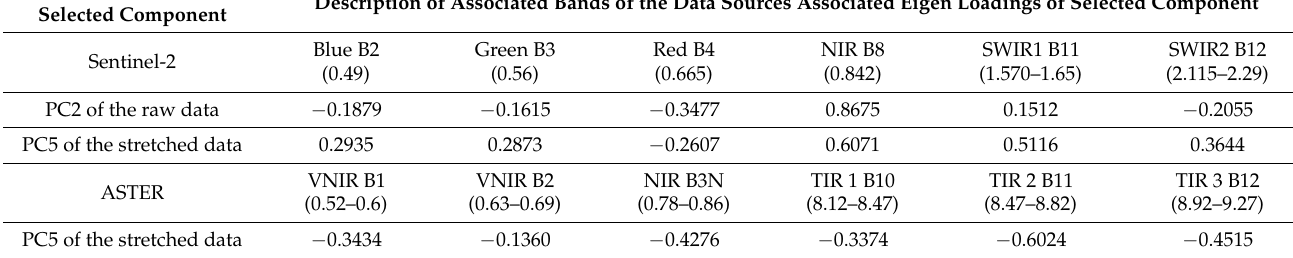
Table 7. Eigenvalues for the selected band ranges/center (in µ m) and the components of Nagarparkar granite. Data Sources Selected Component